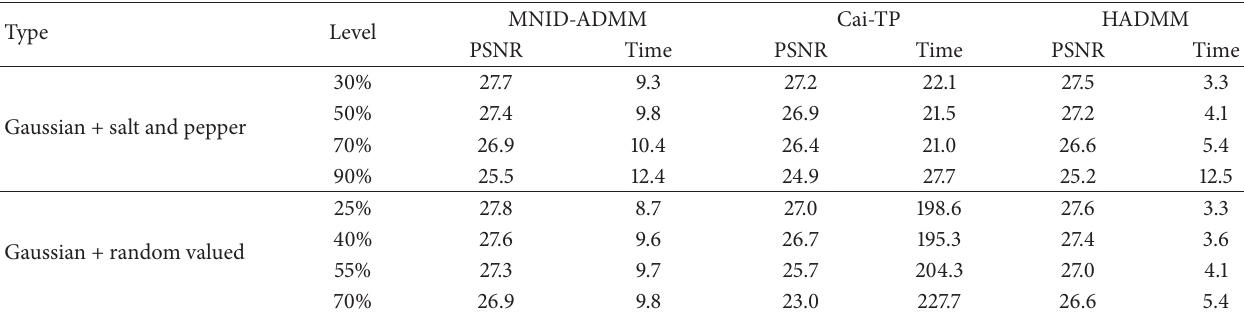
Gaussian + random valued